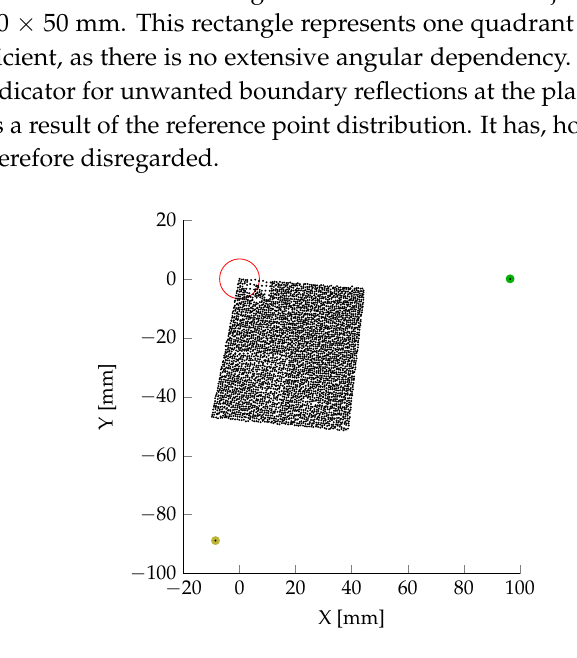
Figure 4. Point distribution. Actuator: red; geometrical reference points: green and